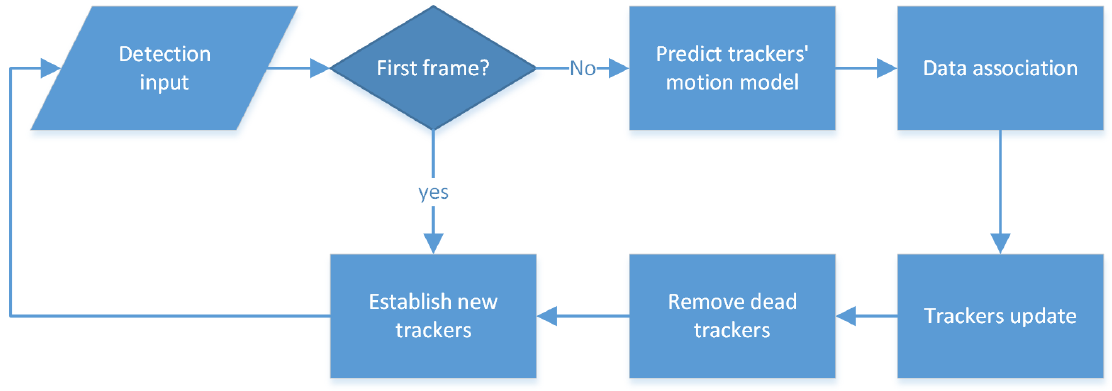
Figure 5. Overall flow of the tracking